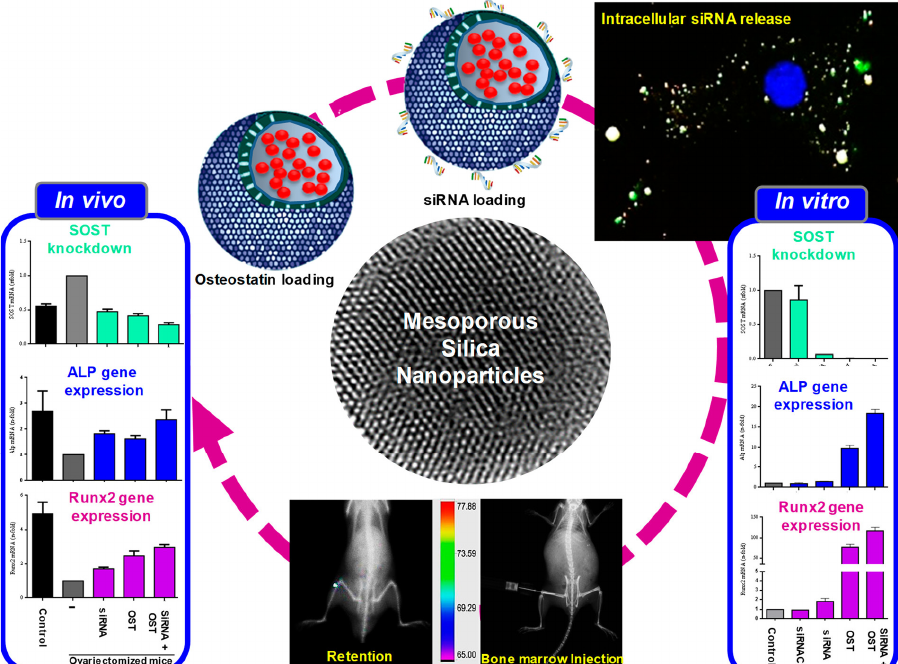
Figure 8. Schematic representation of the designed nanocarrier based on mesoporous silica nanoparticles loaded with osteostatin and siRNA to knockdown SOST and promote the expression of early markers of osteogenic differentiation both in vitro and in vivo . Reprinted with permission from Ref. [210]. 2019, American Chemical Society.